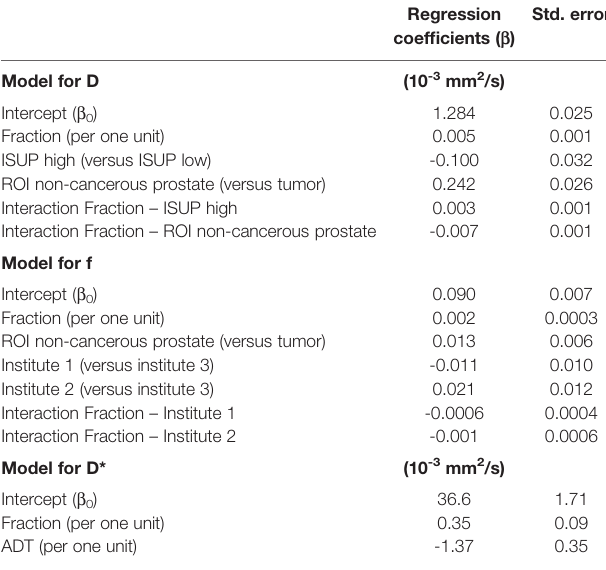
TABLE 3 | Model parameters of the mixed effects models for D, f, and